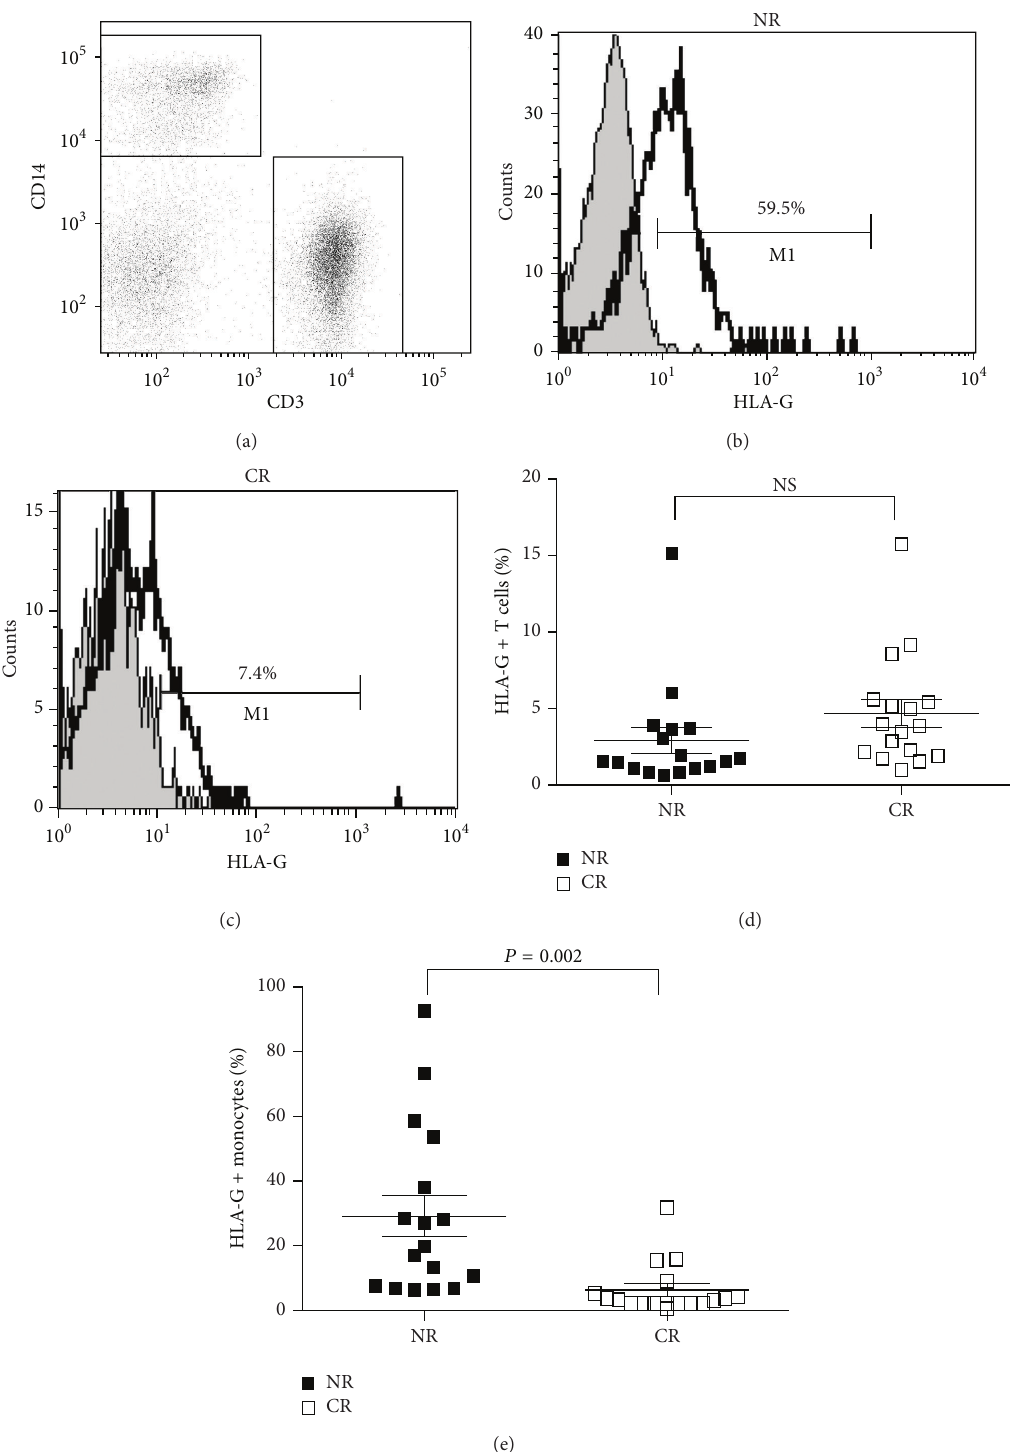
Figure2:IncreasedpercentagesofHLA-G-positivemonocytesinnonrejectingkidneytransplantpatients.(a,b,c)PBMCsfromrenalallograft patientsinboththenonrejectedgroup(NR)andchronicrejected(CR)groupswerestainedwithanti-CD3,anti-CD14,andanti-HLA-GmAbs, and FACS analysis was performed. Representative flow cytometric analysis of PBMCs from indicated groups of renal allograft recipients is shown. (b and c) Histograms shown here were gated on a CD14-positive population. Filled histograms represent the isotype control. Numbers indicate the percentage of HLA-G-positive monocytes. (d) Numbers indicate the percentage of HLA-G-positive T cells in both groups of patients (gated on CD3-positive population). Filled boxes represent data from NR (𝑛 = 17) and open boxes represent data from CR (𝑛 = 17) patients. (e) Numbers indicate the percentage of HLA-G-positive monocytes in both groups of patients (gated on CD14-positive population). Data are shown as mean ± SD and analyzed by Student’s 𝑡 -test. NS: not